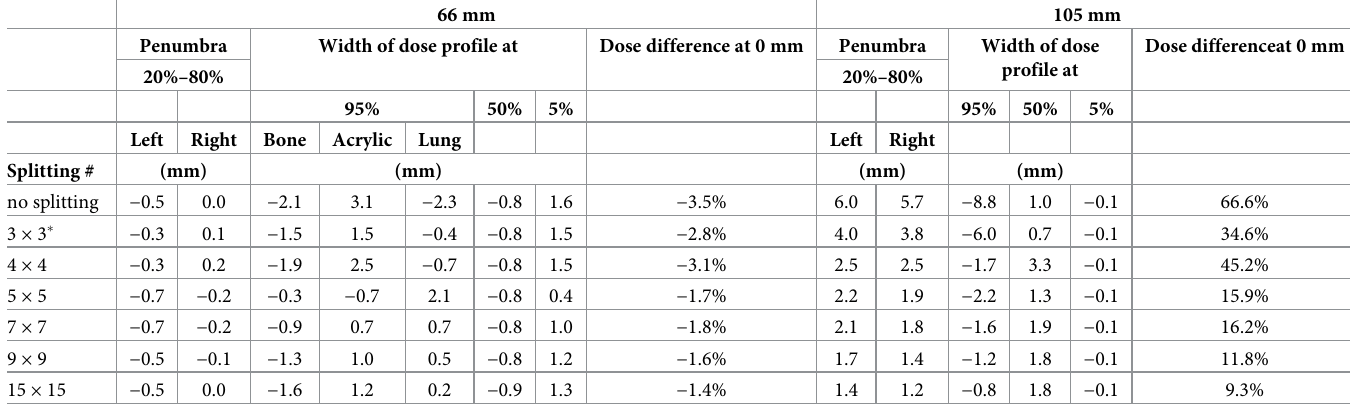
Table 1. Comparison of the dosimetric parameters of lateral-dose profiles penetrating the heterogeneous materials shown in Fig 9(C) and 9(D).